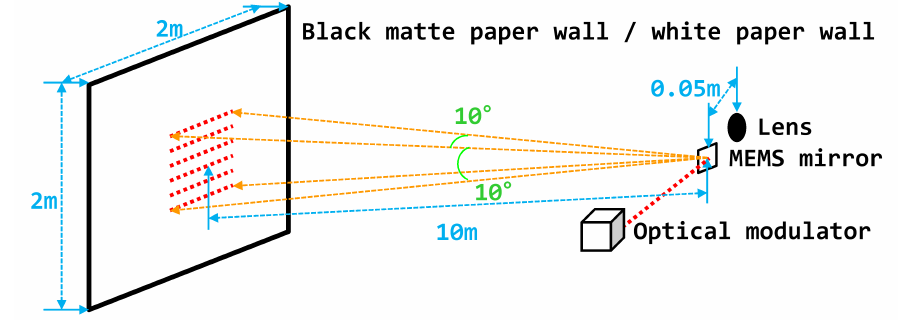
Figure 5. Operating condition and optical structure of the prototype LIDAR system. Table 2. Operating characteristics of the two